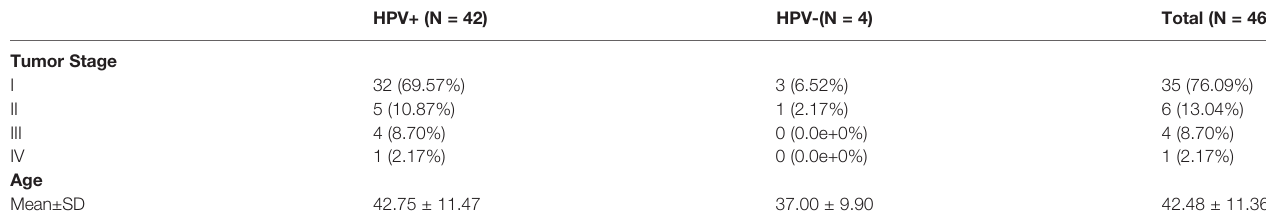
TABLE 1 | HPV+ and HPV- CESC patient information. The tumor stages and age information of HPV+ and HPV- CESC patients.